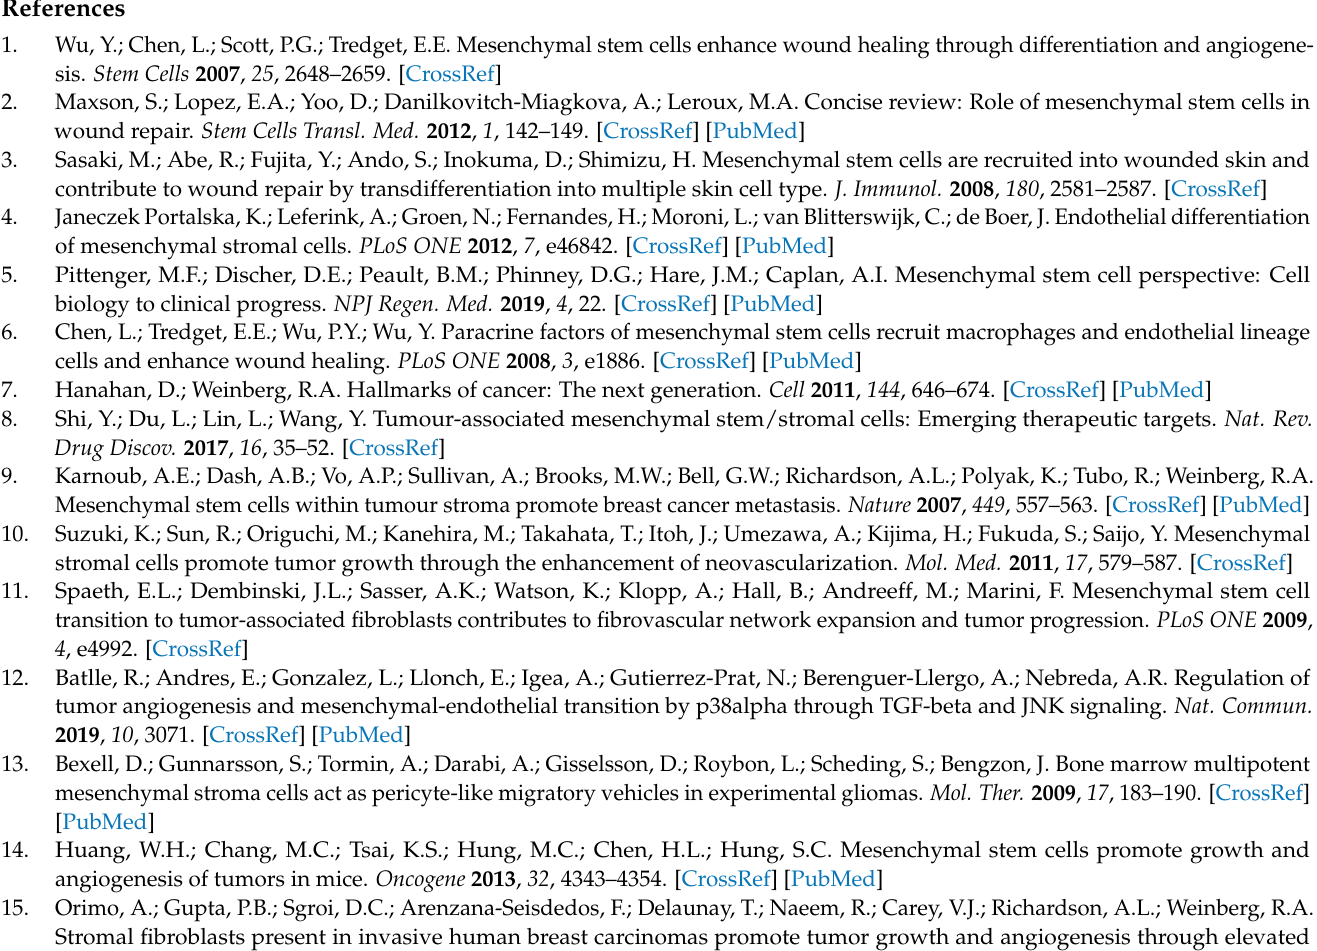
Figure 1A,D; Figure S2: Full unedited blots of Figure 2A–K; Figure S3: Protein expression levels of HIF-1 α in BM-MSCs transfected with HIF1A siRNA; Figure S4: qRT-PCR analysis of VEGFA